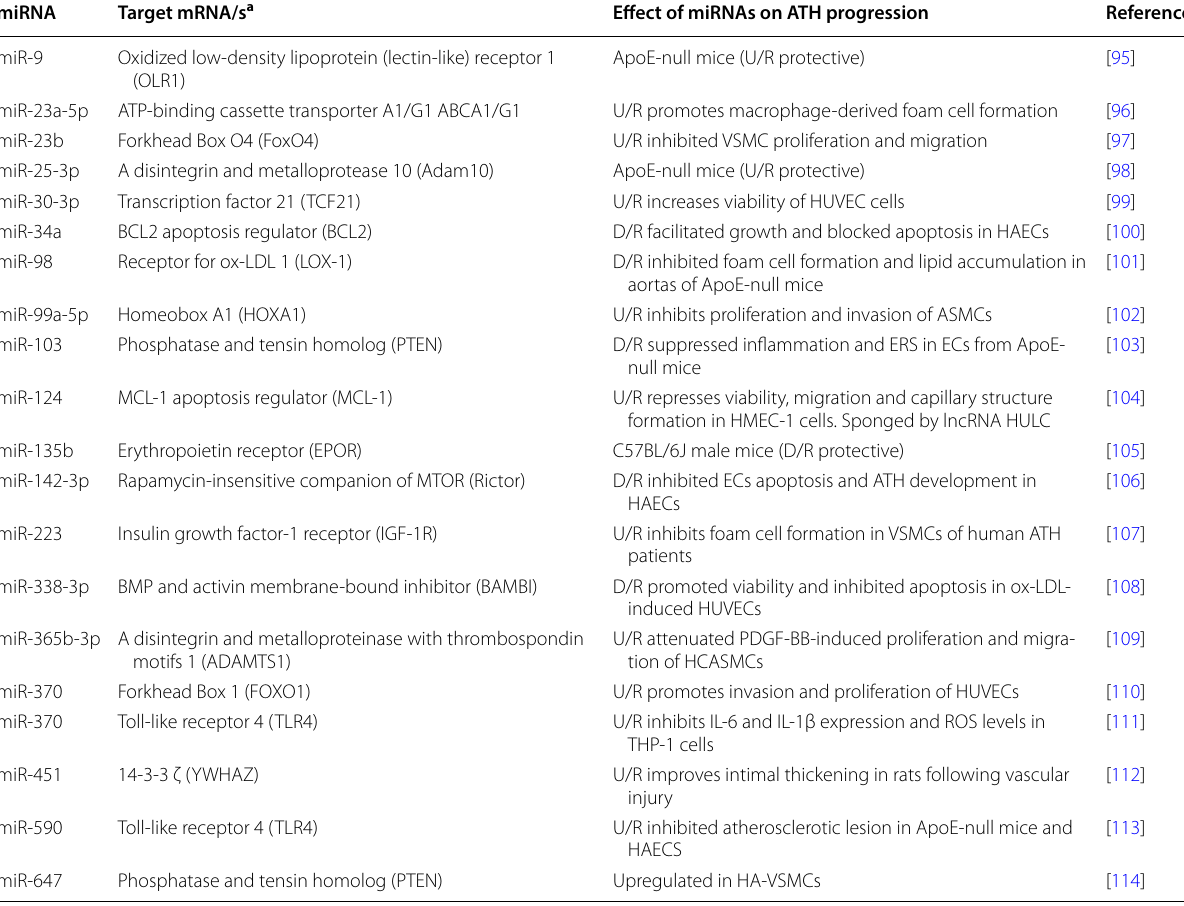
U/R Up-regulation, D/R